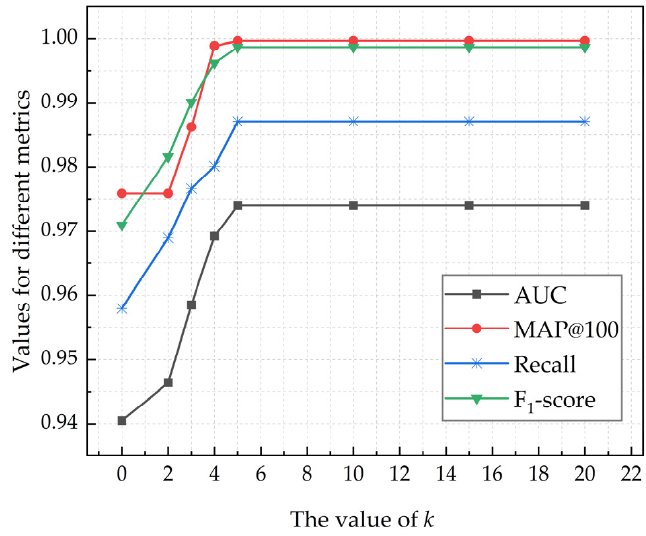
Figure 6. Experimental results of stacking structure with different k values.